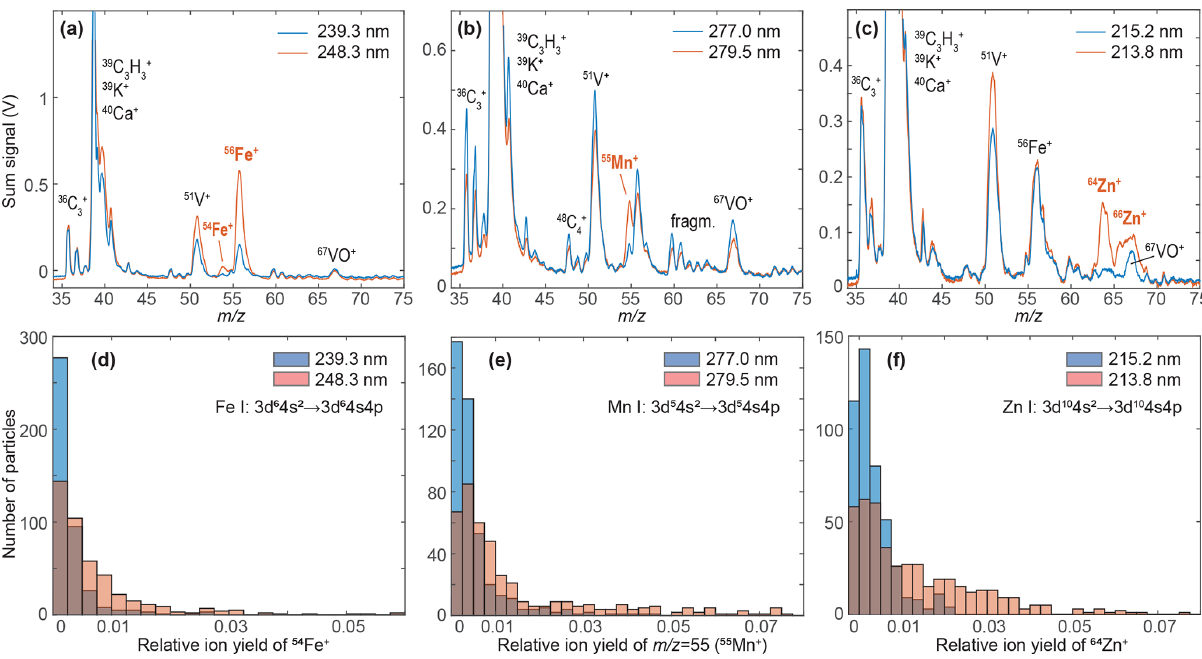
Figure 3. Accumulated cation mass spectra ( n = 400) of re-dispersed urban dust particles (reference material NIST 1649b). Using the tuneable OPO, the spectra were recorded at resonance wavelengths of each metal (red) and for the nonresonant case at a slightly different wavelength (blue). While carbon and molecular fragment signals are similar in the pairwise comparison, the resonant enhancements for (a) Fe, (b) Mn and (c) Zn are clearly visible. Complete bipolar mass spectra and the size distribution are shown in Fig. S5. (d–f) The single- particle distribution of the relative ion signals illustrates that the resonant ionization enhancement allows metal detection for many more particles. The respective resonance wavelengths (red) address the indicated transitions.